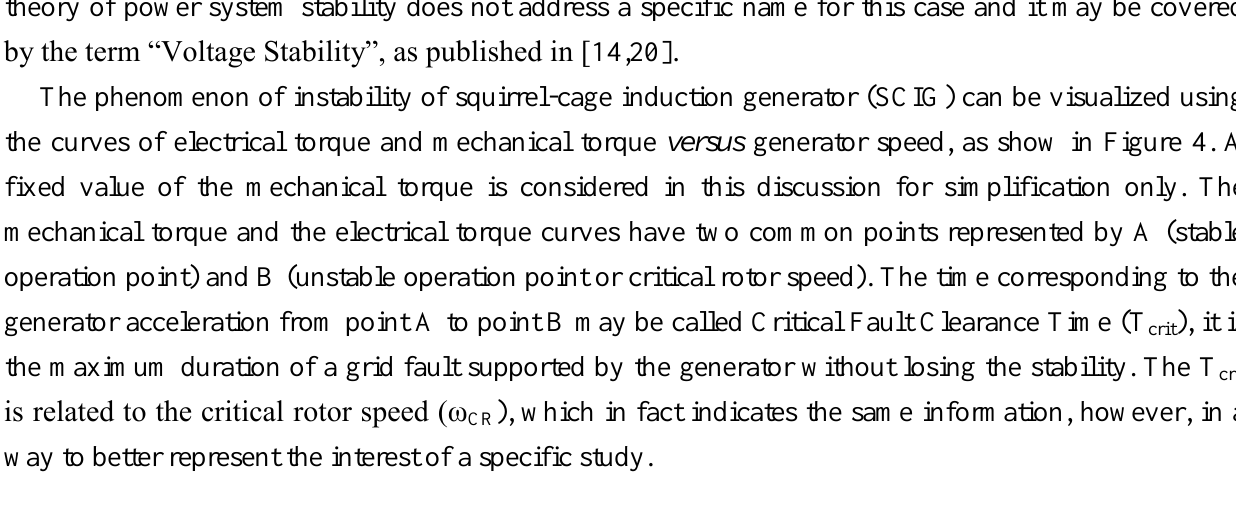
Figure 4. Negative electrical torque (T E ) and mechanical torque (T M ) vs. generator speed.